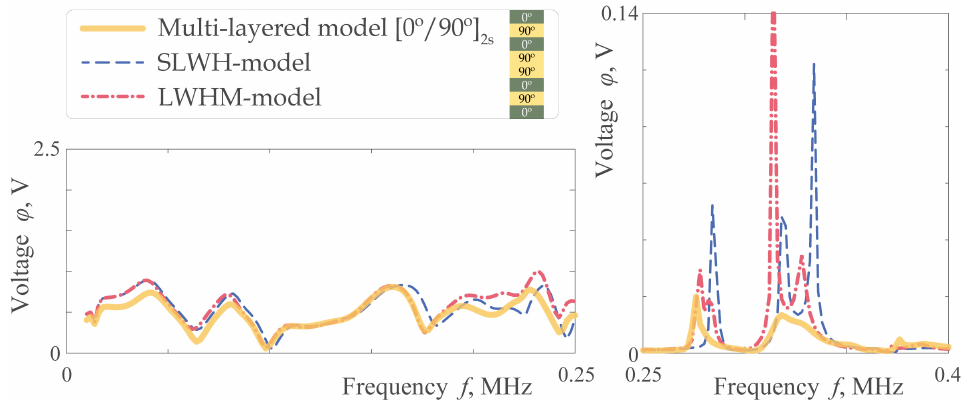
Figure 15. Voltage ¯ ϕ ( f ) measured at the sensor on the surface of the multi-layered waveguide [ 90 ◦ ,0 ◦ ] 2s (thick solid line), and waveguides with effective properties estimated according to the SLWH-model (thin solid line) and the LWHM-model (dash-dotted line) in the case of the surface- mounted stringer.